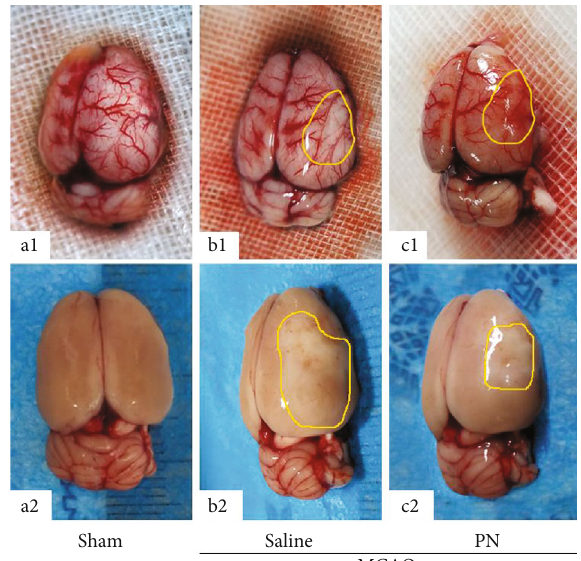
Figure 1: Brain tissue samples of rats from each group. (a) Sham group, (a1) cerebral vessels are abundant and clearly visible, (a2) brain tissue is full and symmetrical. (b) MCAO group treated with saline, (b1) blood vessels around the infarction show exudation, blocked blood vessels are seen to be collapsed and atrophied, and (b2) brain tissue is swollen and white. (c) MCAO group treated with PN, (c1) blood vessels around the infarction are mostly new, with less exudation than MCAO group and (c2) brain tissue is not swollen obviously. The yellow lines indicate the infarct area. Similar experiments were performed at least 5